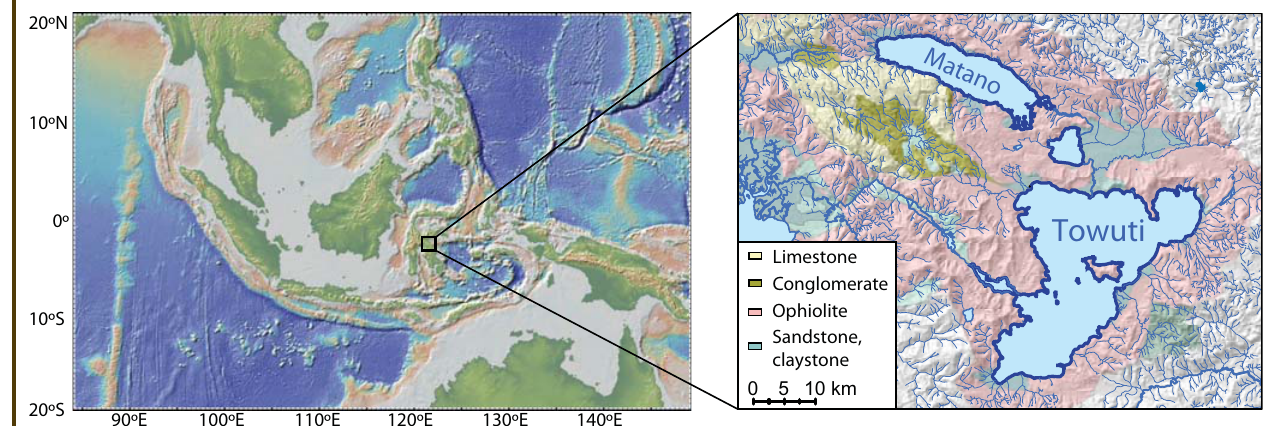
Figure 2. Topographic map of Indonesia and surrounding countries showing the location of the Malili Lakes region within Sulawesi. At right is a simplified geologic map of the Malili Lakes, courtesy of PT Vale-Inco